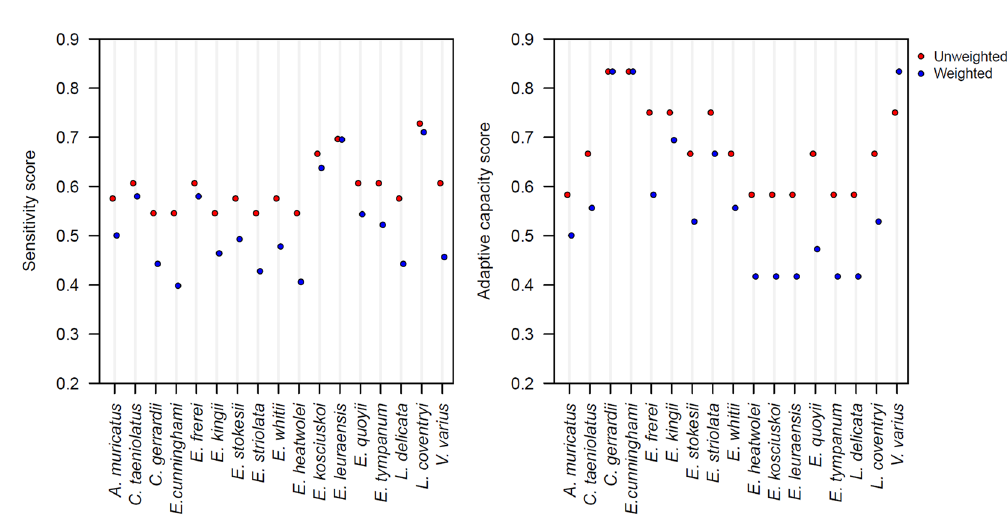
Figure 2. Weighted and unweighted scores of sensitivity and adaptive capacity of the 17 Australian lizard species to climate change. Score ≥ 0.67 is high, from 0.33 to 0.66 is moderate and < 0.33 is